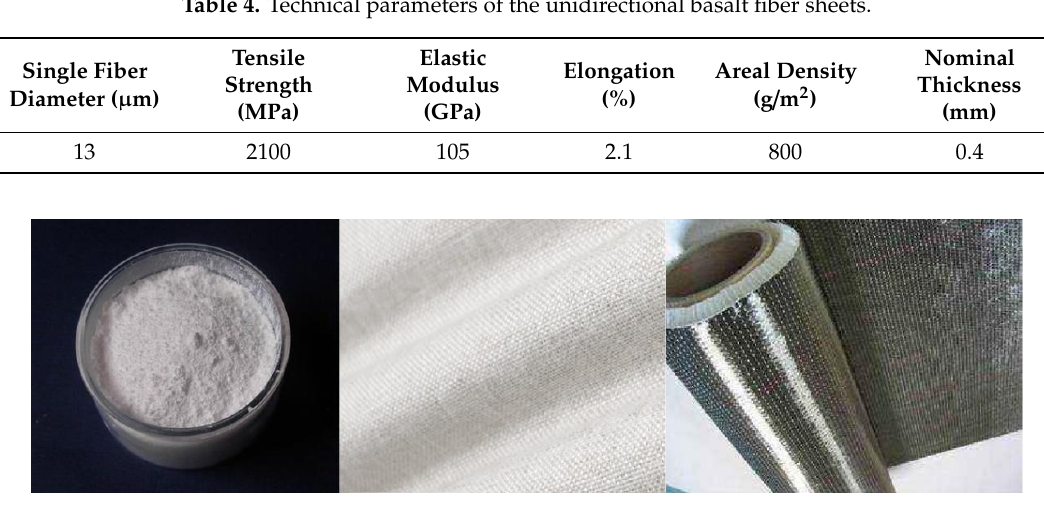
Figure 1. Photos for the nano-TiO 2 , the flax fiber sheets grafted with nano-TiO 2 , and the basalt fiber sheets.